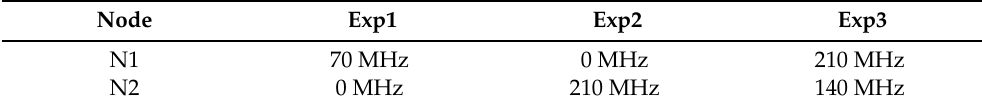
Table 1. Vibration frequencies monitored by nodes N1 and N2.